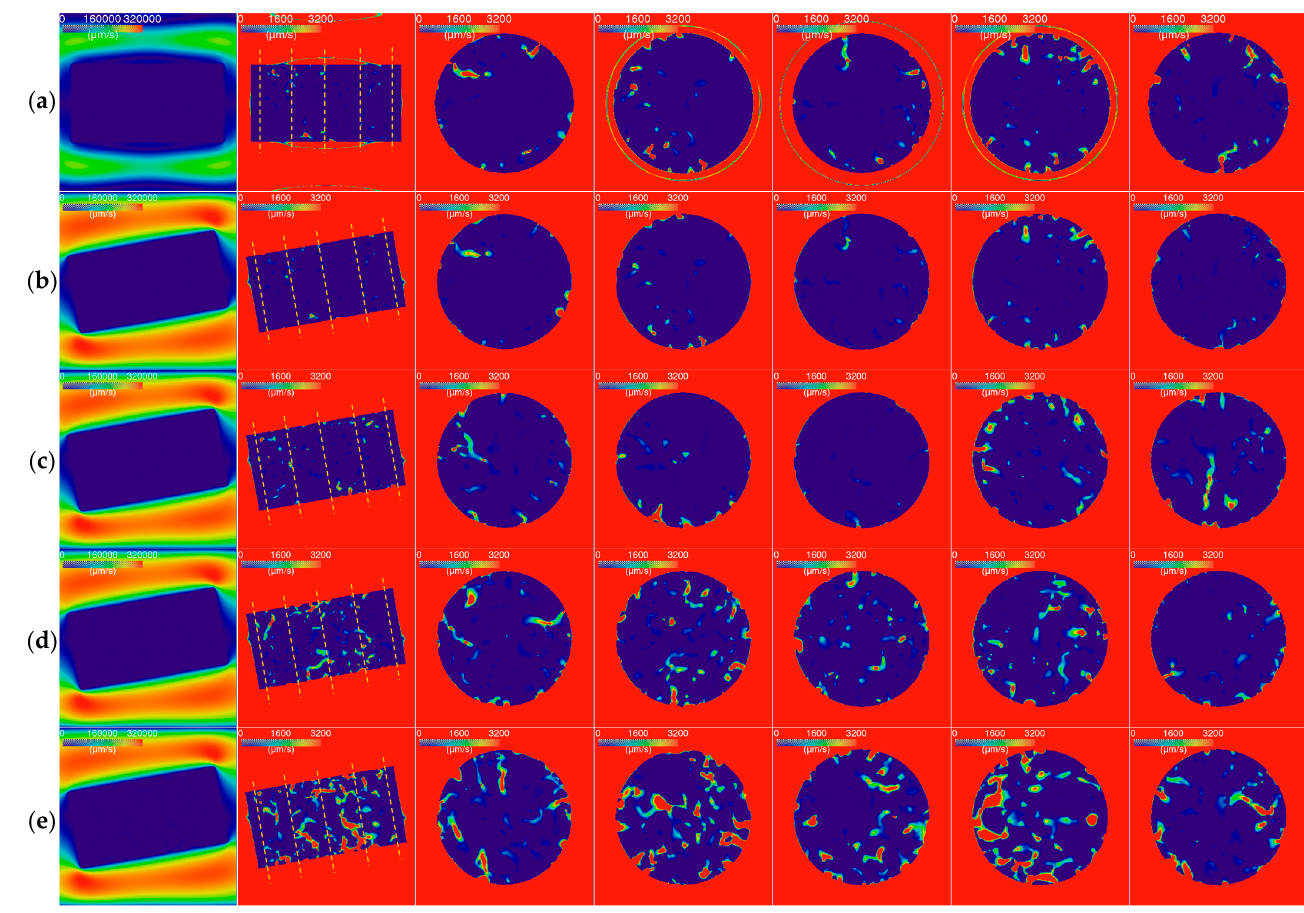
Figure 16. Gas velocity distributions for partially SiC-coated graphite specimens: ( a ) as-received without rotation; ( b ) as-received; ( c ) oxidized for 4 min; ( d ) oxidized for 8 min; ( e ) oxidized for 24 min.